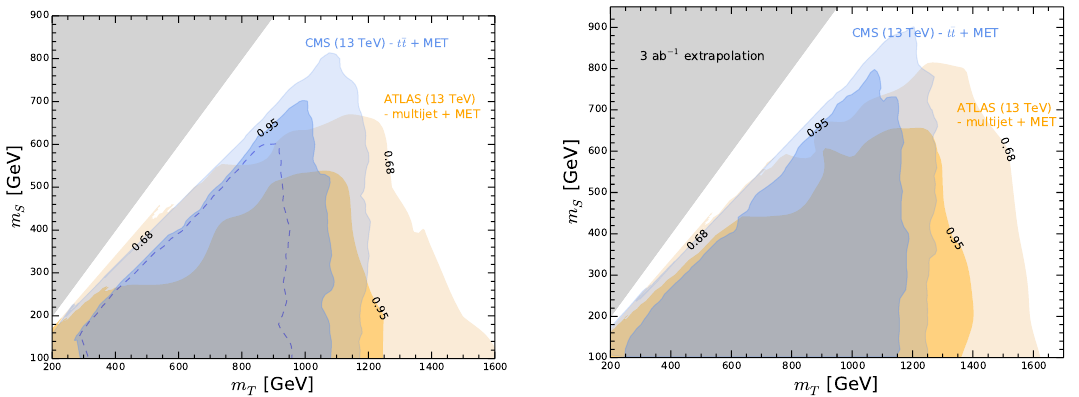
Figure 8 . Collider constraints for the t ¯ t + /E channel for both analyses of interest, indicating T the 95 % CL (darker regions) and 68 % CL (lighter regions) exclusion contours. The left figure indicates LHC run-2 exclusions with a luminosity of 139 fb − 1 , while the right figure presents the extrapolation of the bounds to 3 ab − 1 . The dashed line featured in the left plot indicates the exclusion obtained from the CMS-SUS-17-001 analysis featuring 35 . 9 fb − 1 of data.